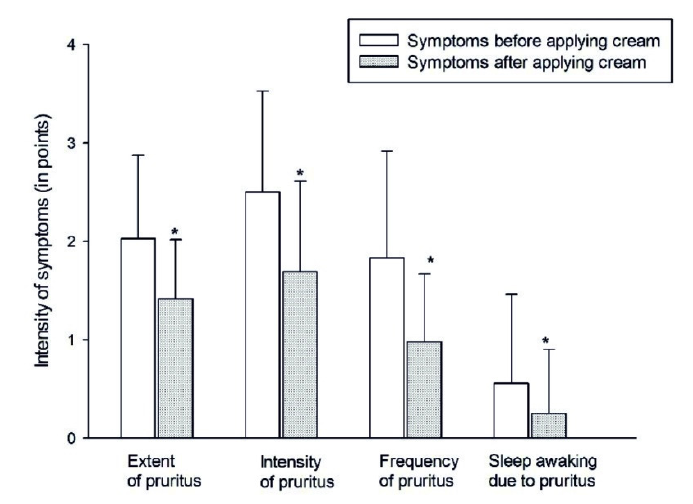
Figure 4. Comparison of termoquality index survey results before and after the usage of cream with 2% of ecdysteroids extract from the S. coronata herb. *—statistically significant difference compared to the result observed previously ( p < 0.05; the Wilcoxon signed-rank test).